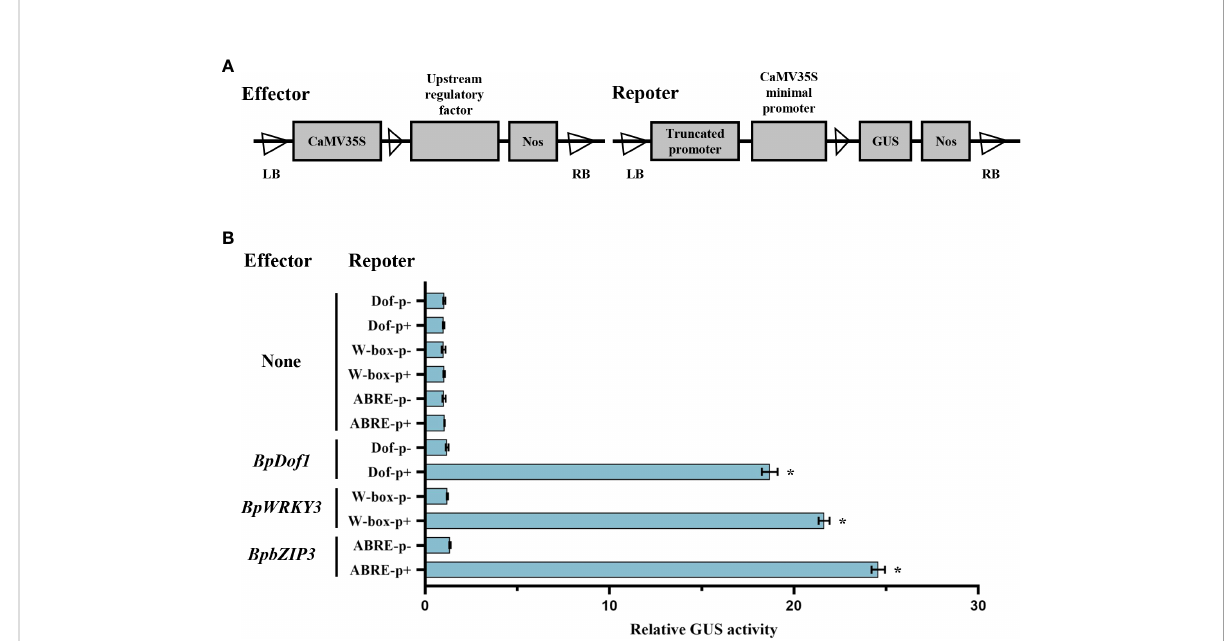
FIGURE 7 Analysis of upstream regulatory factors binding to the truncated promoters including Dof, W-box, or ABRE elements in birch plants. (A) Schematic representation of upstream regulatory factor and the truncated promoter including or lacking the Dof, W-box, or ABRE elements used in the co-expression of effector and reporter in birch plants. The upstream regulatory factor: pROKII-35S:: BpDof1 , pROKII-35S:: BpWRKY3 or pROKII-35S:: BpbZIP3 . Dof p+, W-box p+, and ABRE p+: the truncated BplMYB46 promoter containing Dof, W-box, and ABRE elements, respectively. Dof p-, W-box p-, and ABRE p-: the truncated BplMYB46 promoter lacking Dof, W-box, and ABRE elements, respectively. (B) Transient co-transformation of effector and reporter constructs in birch plants to study the binding of BpDof1, BpWRKY3 and BpbZIP3 to Dof, W-box, and ABRE elements, respectively. GUS activity indicated the binding af fi nity of different upstream regulatory factor to the speci fi c truncated promoter. Error bars indicate the standard deviation of three biological replicates. * indicates a signi fi cant difference ( P <